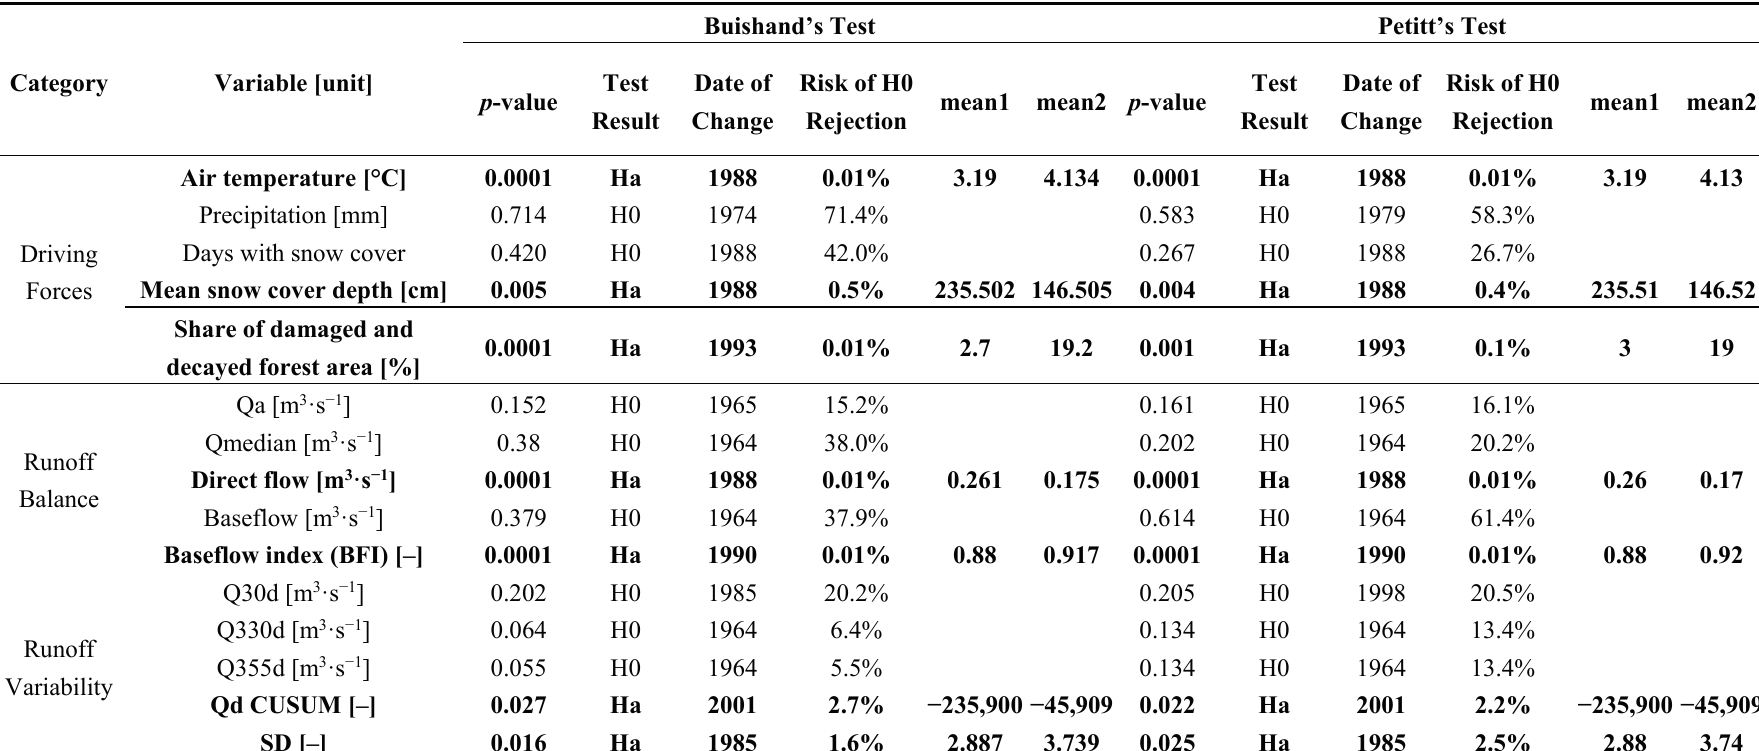
Table 2. Homogeneity tests and detection of change points in the assessed hydro-climatic indicators using Buishand’s and Petitt’s tests. In bold are marked indicators with p-value lower than 0.05, mean1 and mean2 are the mean values of indicator in periods before and after change point. Underlined are the years of change with lower p-values resulting from both tests, applied as the breakpoints for calculation of trend